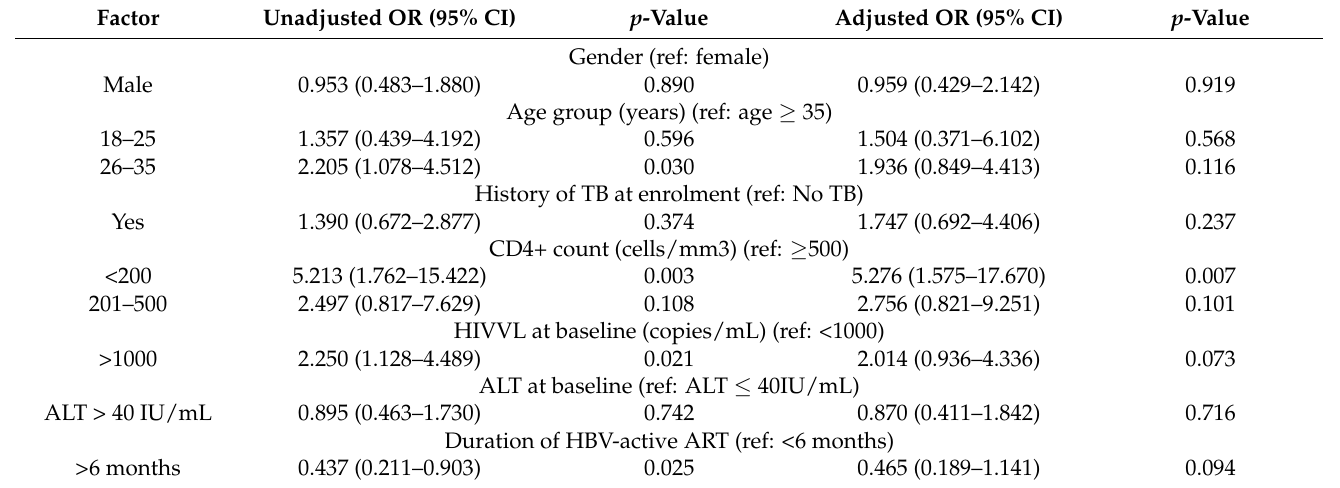
Table 2. Factors associated with HBV viraemia at follow